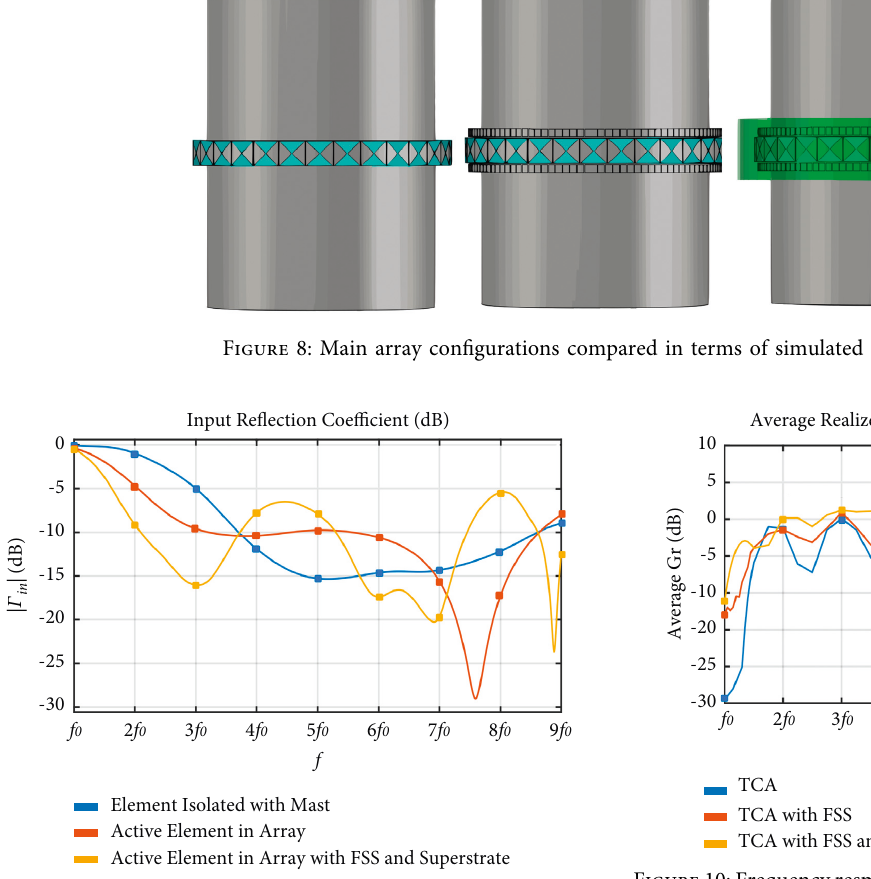
Figure 9: Frequency responses of the absolute value of the input reflection coefficient (dB).